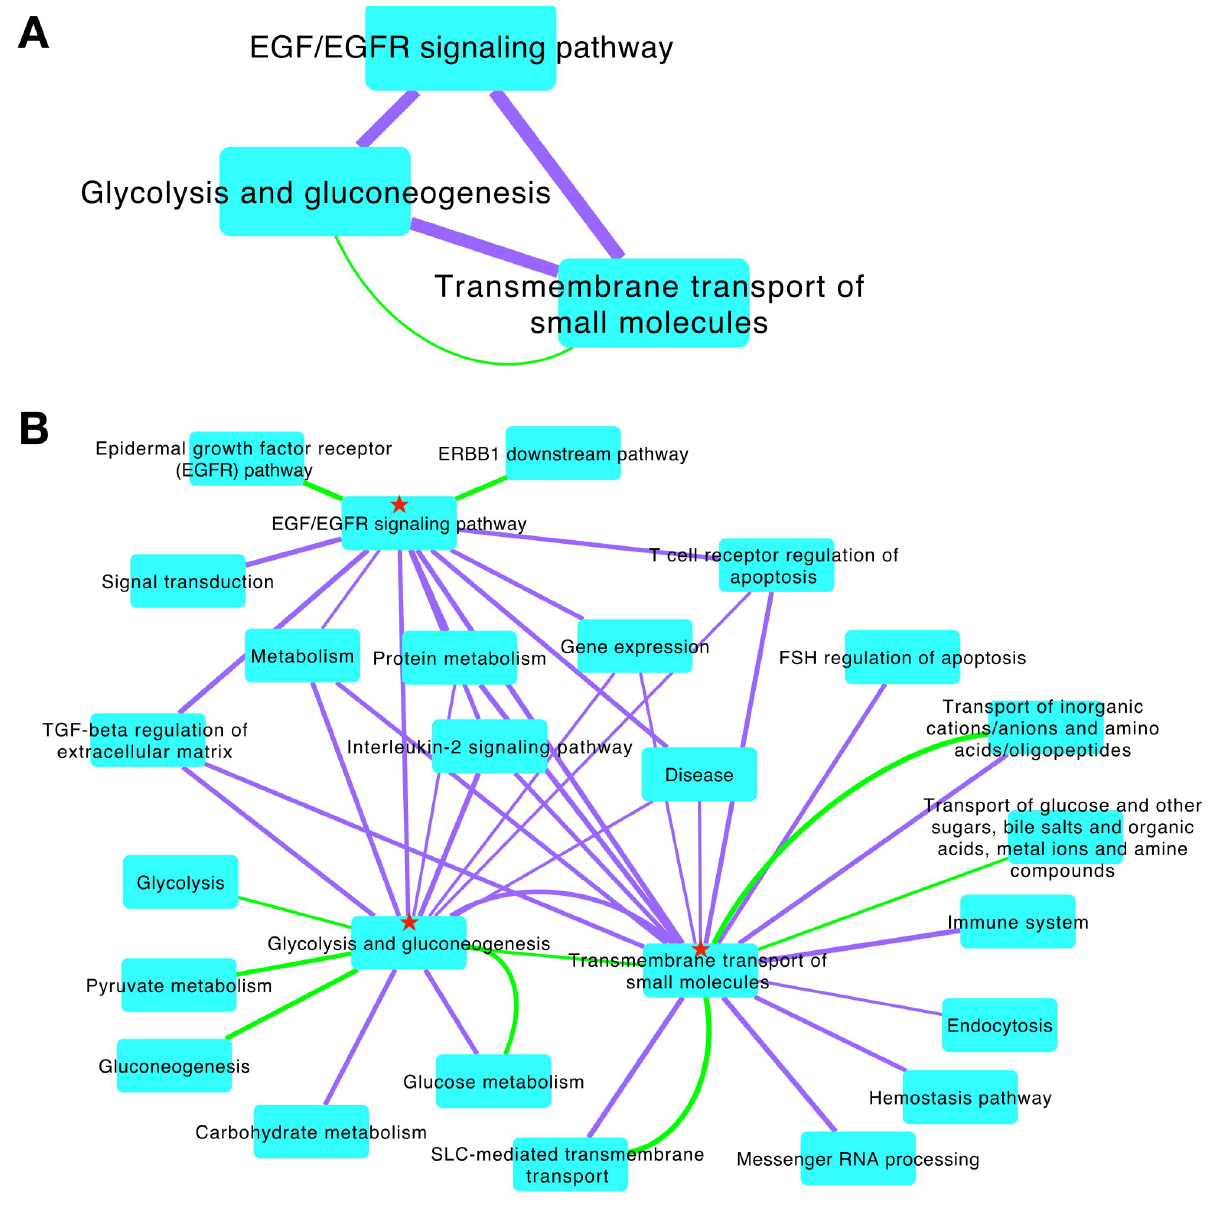
Fig 2. Pathway crosstalk networks with the EGF/EGFR signaling pathway. (A) Three pathways linked by strong PTM cluster weight (purple edges). Note that the EGF/EGFR signaling pathway has no genes in common with Glycolysis and gluconeogenesis and Transmembrane transport of small molecules, but the latter two pathways have 11 genes in common (green edges represent pathway Jaccard similarity). (B) Nearest neighbors of pathways in A ( $ ) with additional edges filtered to show only strong associations (PTM cluster weight > 0.065 and/or pathway Jaccard similarity >